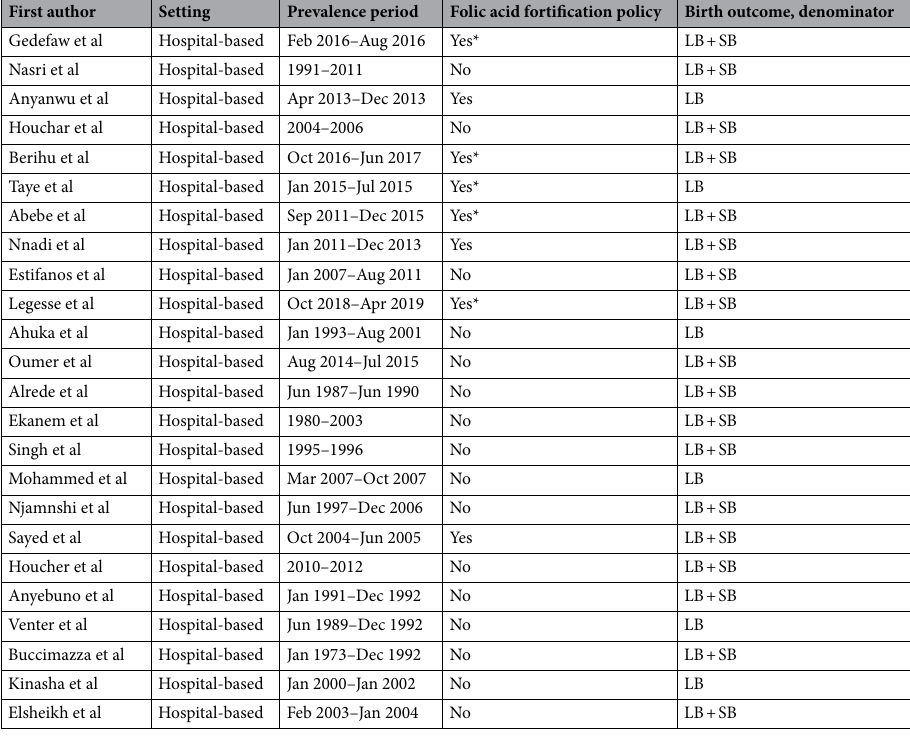
Table 2. The summary of studies included in the systematic review and meta-analysis, 2020. Key: LB: Live births; SB: Stillbirths; *: Voluntary folic acid